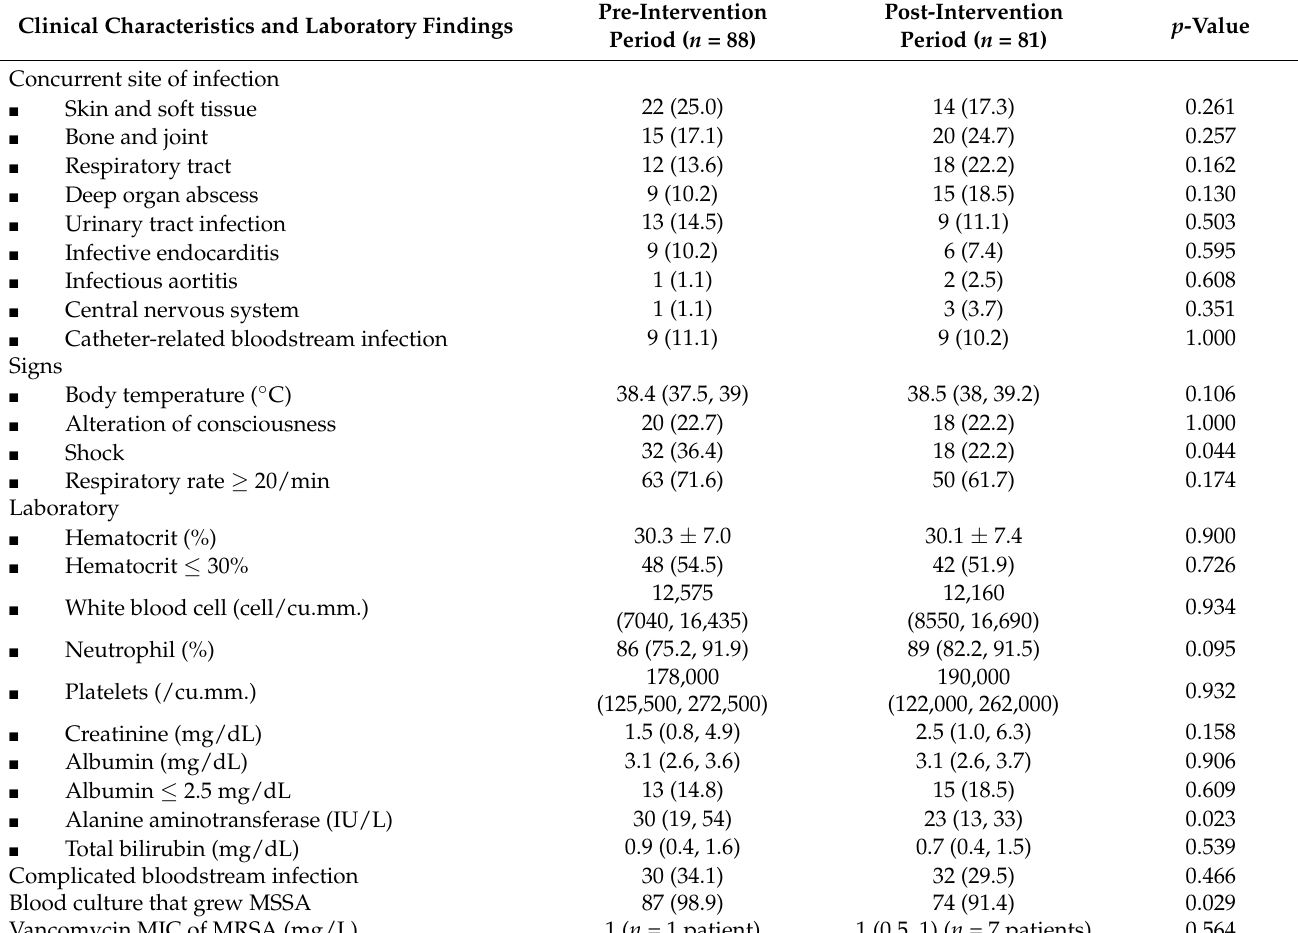
Table 2. Clinical characteristics of patients who had Staphylococcus aureus bloodstream infections. Clinical Characteristics and Laboratory